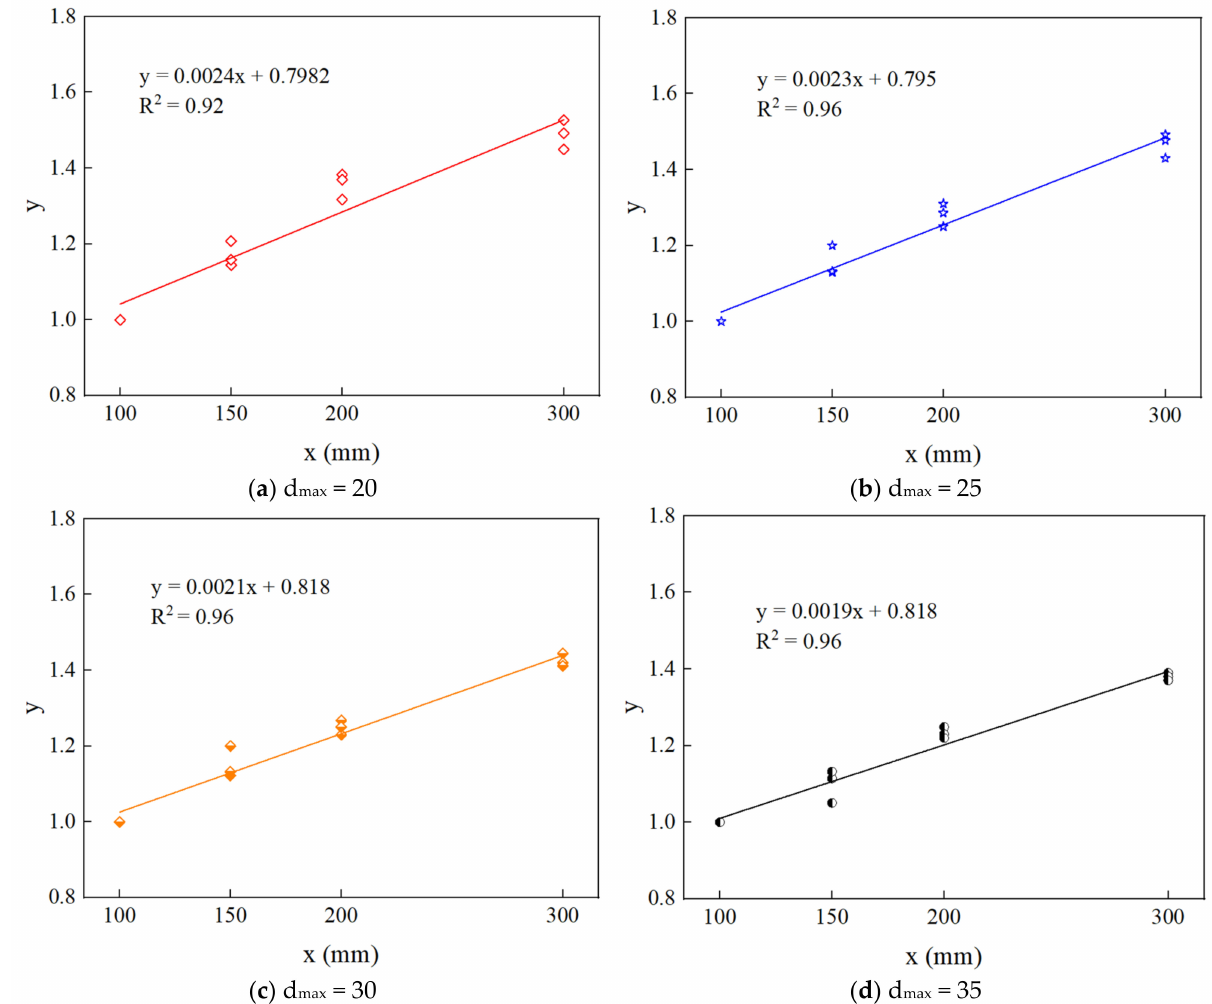
Figure 23. Parameter fitting equation of the Bažant size effect